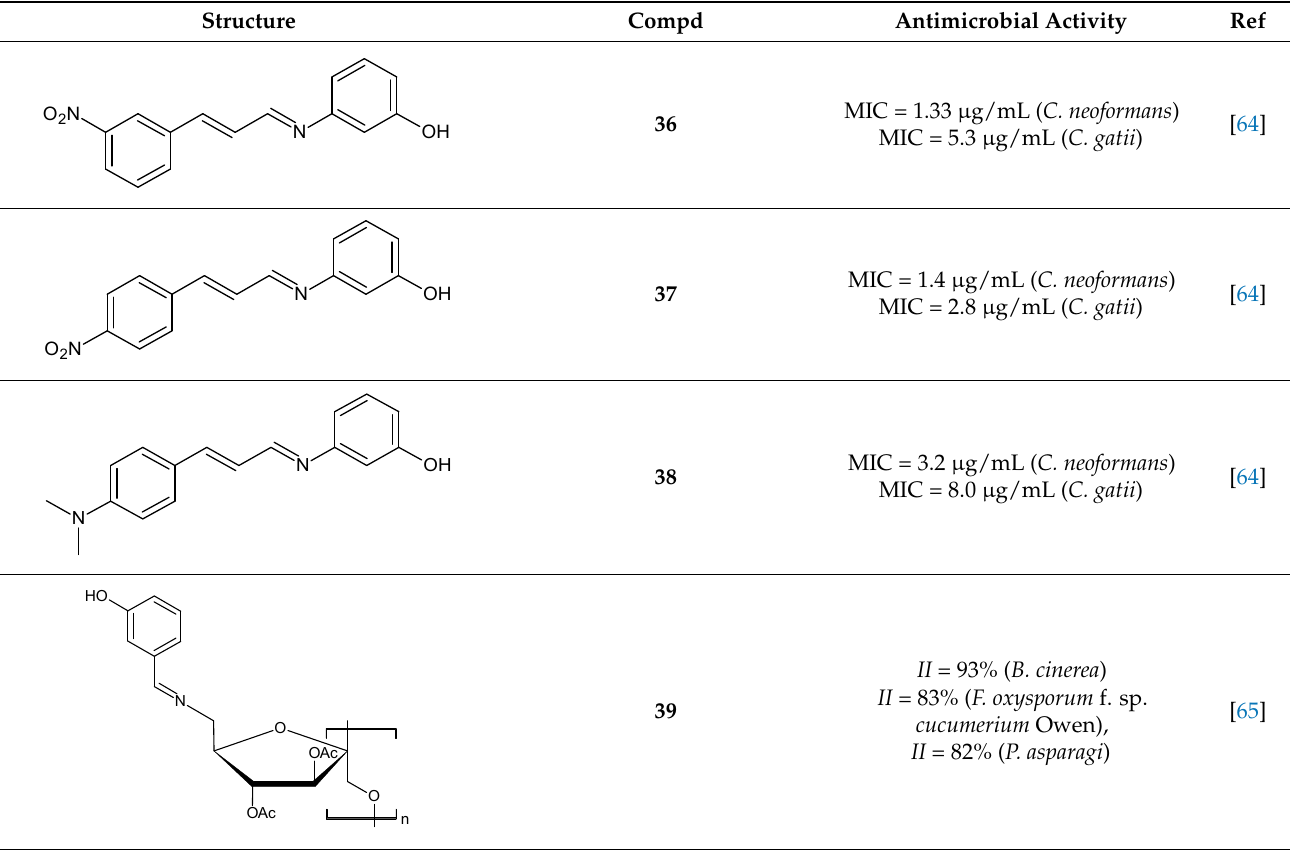
Table 2. Schiff bases with antifungal activity.